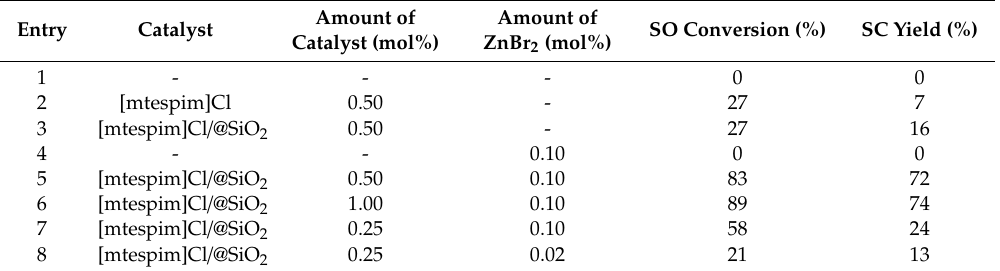
Table 3. Choice of catalytic system for the reaction of CO 2 with SO. Reaction conditions: